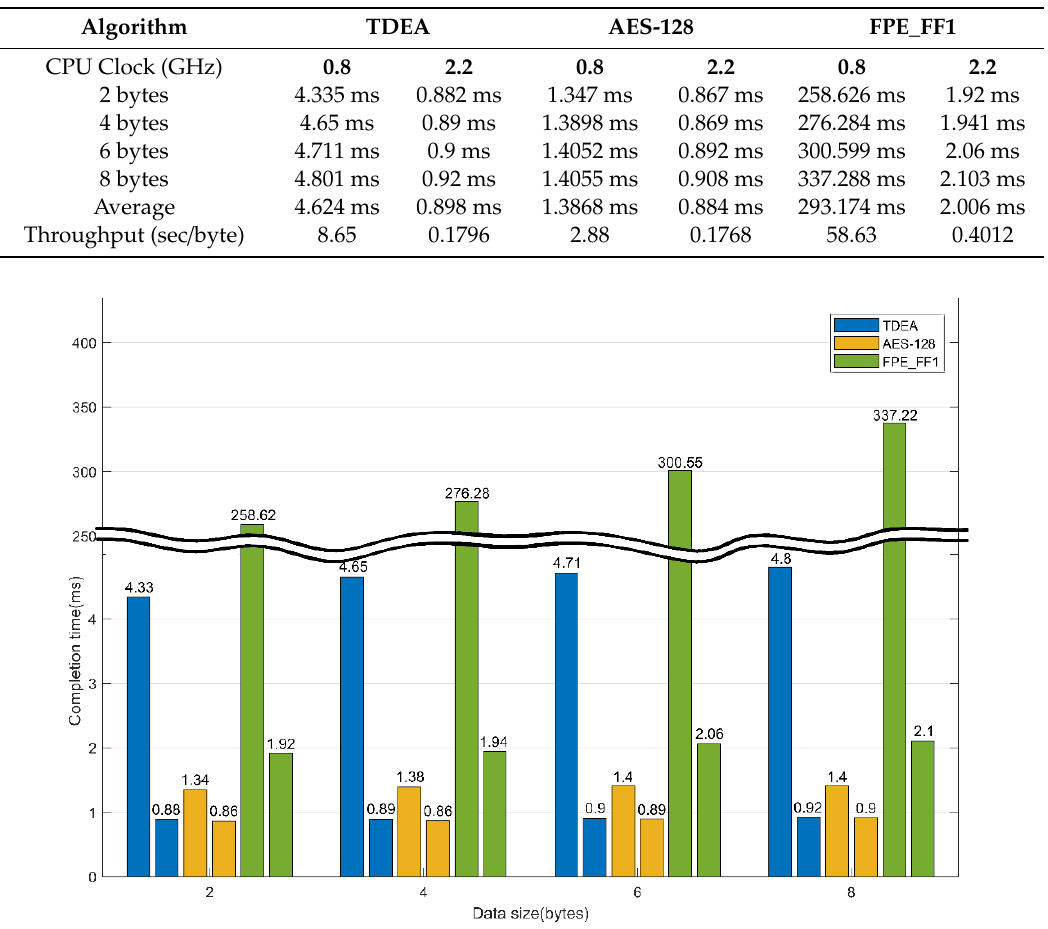
Table 7. Encryption time with 0.8 and 2.2 GHz CPUs.